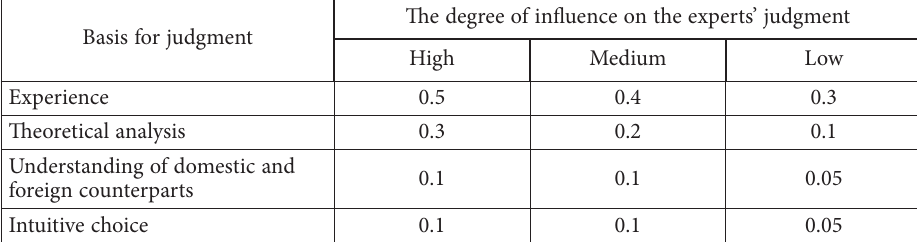
Table 4. Assignment of expert judgment basis (Jiang et al.,